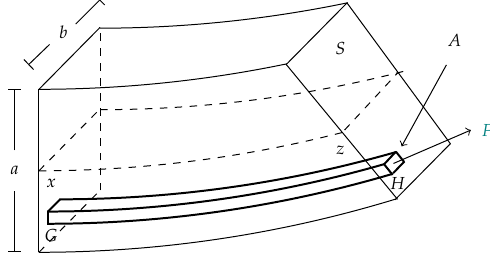
Figure 2. A small element of the beam.